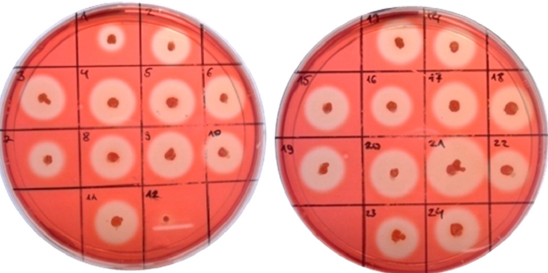
Figure 4. Zones of cellulose hydrolysis formed by the recombinant clones of B. licheniformis containing pBES_cel8A construct with signal peptides library. A strict correlation between the size of the hydrolysis zone and the cellulase activity was not observed. The subtilisin-like signal peptide with one amino acid substitution (me- thionine to valine) as compared to subtilisin SP did show the highest activity—2.97 U at time point (Figure 5).